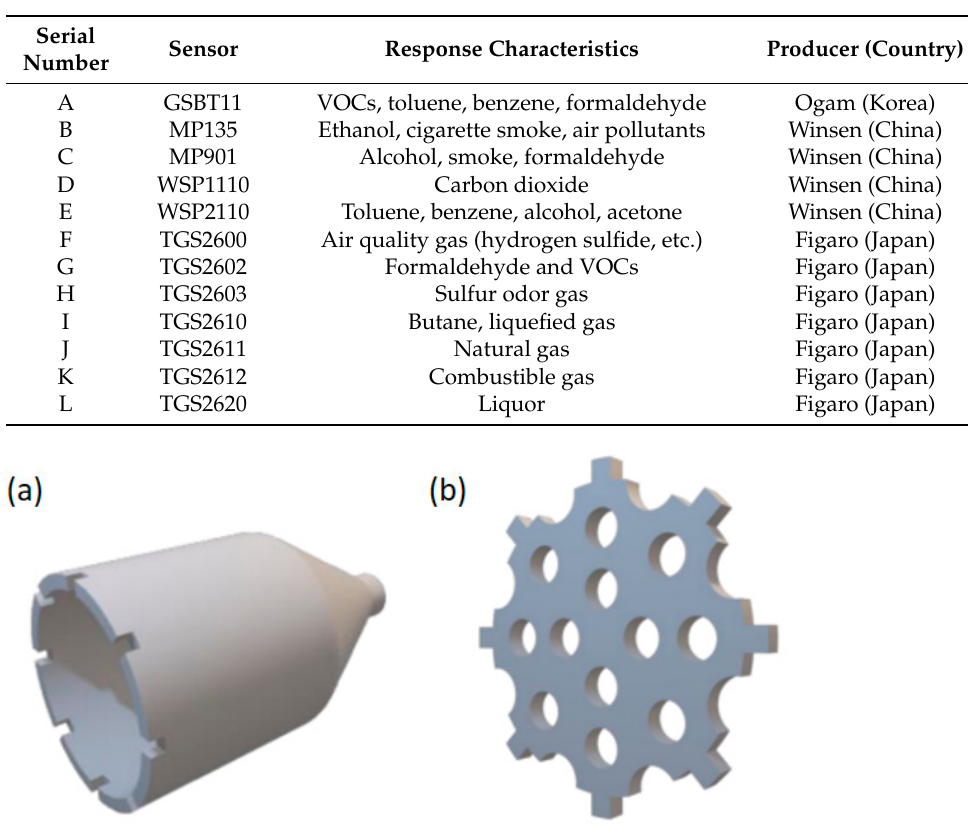
Table 1. Information of the 12 gas sensors.